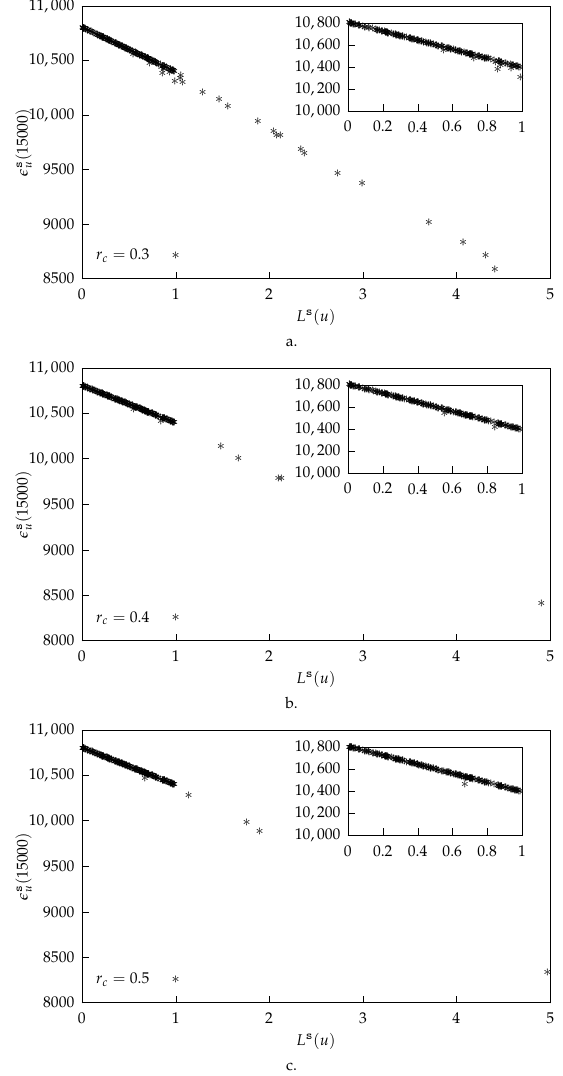
Figure 2. Residual energy of all network nodes at t = 15,000, over the cumulative traffic load L s ( u ) , for three values of r c (( a ) r c = 0.3, ( b ) r c = 0.4, and ( c ) r c =